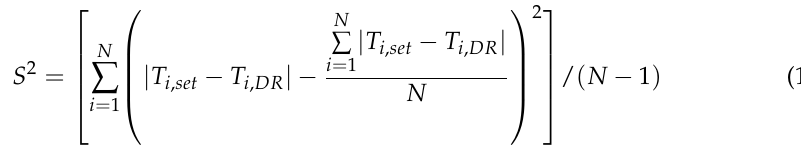
No Figure 6. Optimization process of genetic algorithm. Table 1. Main parameters of the genetic algorithm. Parameter Value Chromosome size 1000 Size of population 80 Probability of crossing 0.7 Probability of mutation